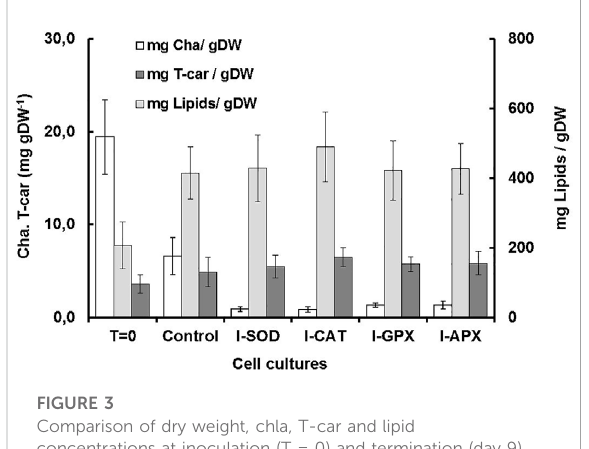
FIGURE 3 Comparison of dry weight, chla, T-car and lipid concentrations at inoculation (T = 0) and termination (day 9) during the carotenogenesis process for all